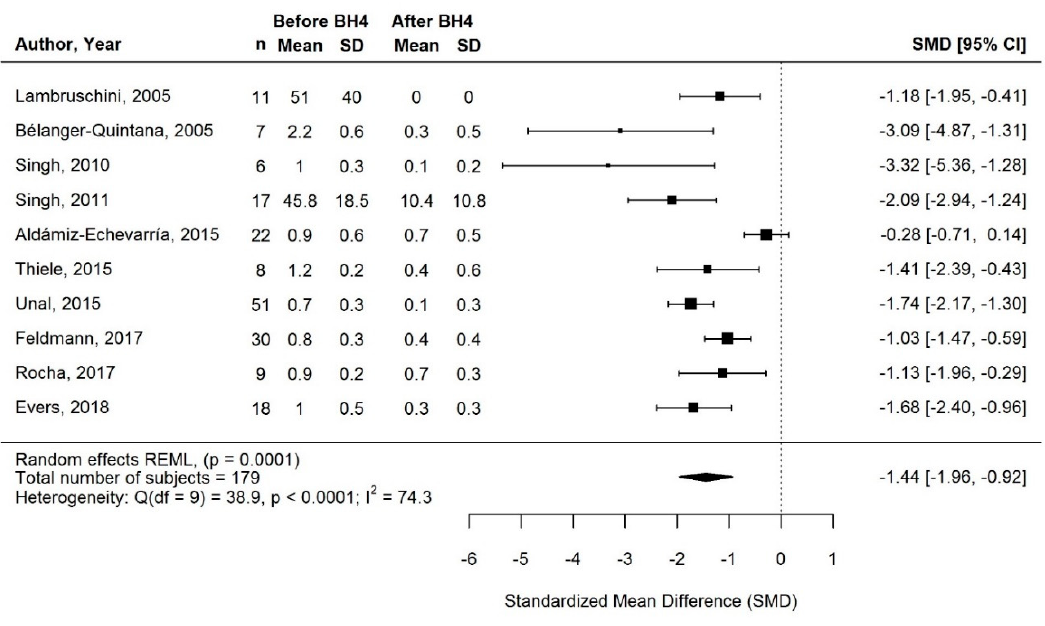
Figure 4. Standardized change in protein equivalent intake from protein substitute of long-term responders on BH4 treatment. Means and SDs before/after BH4 are gram protein equivalent per day for Lambruschini (2005) and Singh (2011), and gram per kilogram bodyweight per day for all other studies. Abbreviations: BH4, tetrahydrobiopterin; CI: confidence interval; n: sample size; SD: standard deviation; SMD, standardized mean difference.